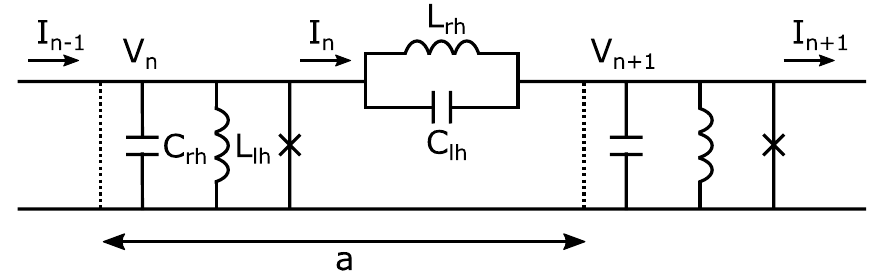
Figure 1. Schematic representation of the composite right/left-handed nonlinear transmission line. Each unit cell consists of the series branch elements and the shunt branch elements. In the series branch, a linear inductive element of inductance L rh is arranged in parallel with a linear capacitance C lh . These constitute the linear dispersive element of the line. While in the shunt branch, a linear inductive element of inductance L lh is also arranged in parallel with a linear capacitor of capacitance C rh as well as the Josephson element (represented by ) which is responsible for the nonlinearity of the system. The dotted vertical lines mark the unit cell of the × lattice with the length a